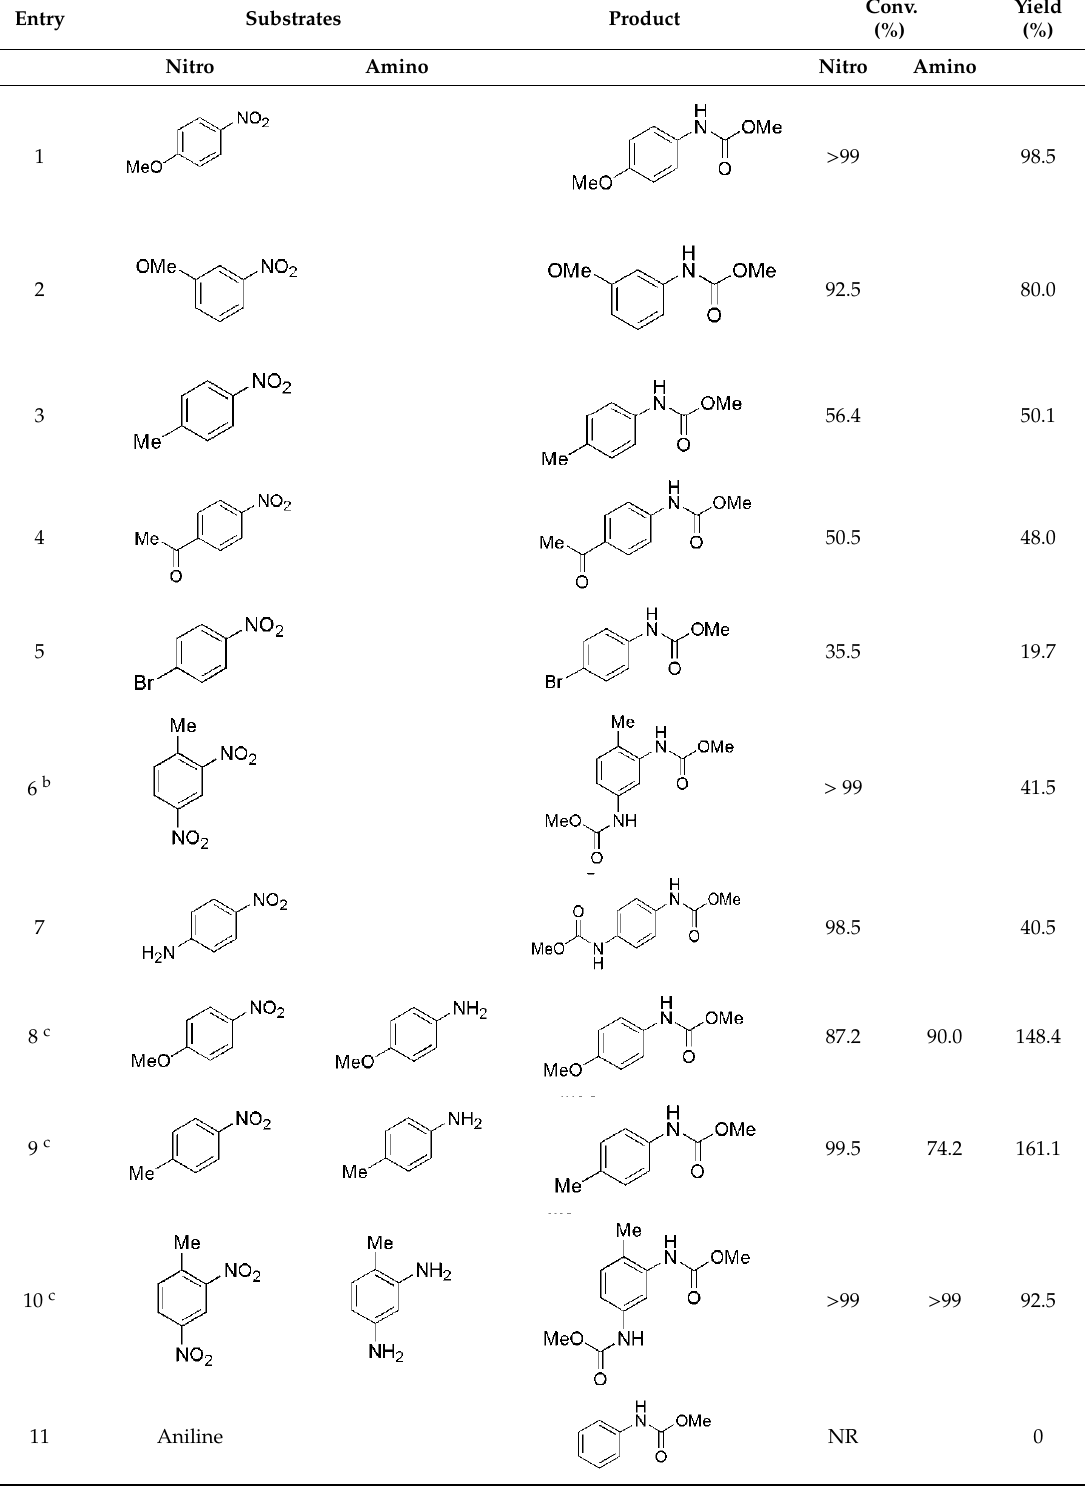
Table 4. Reductive carbonylation of various nitro compounds a